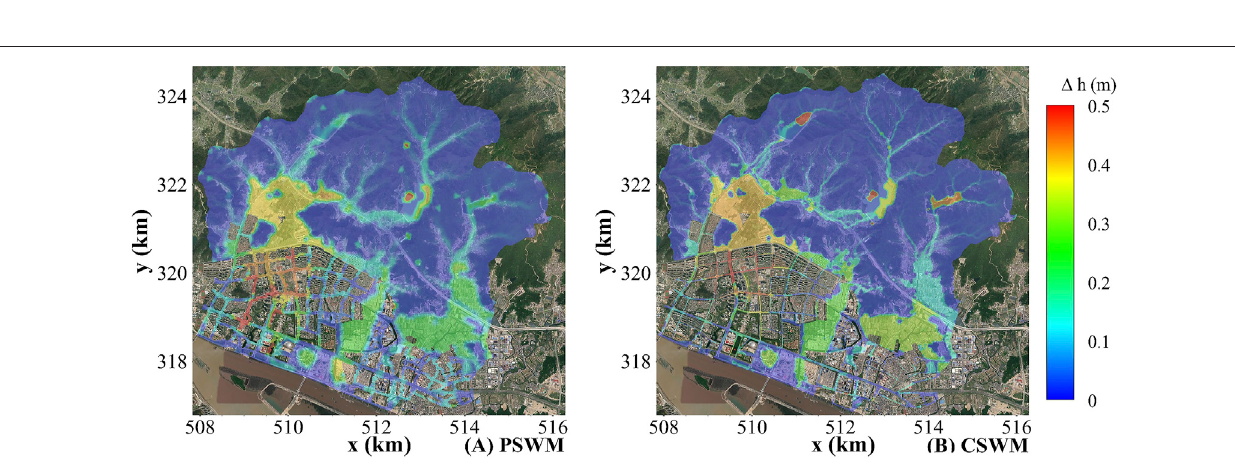
Frontiers in Earth Science |